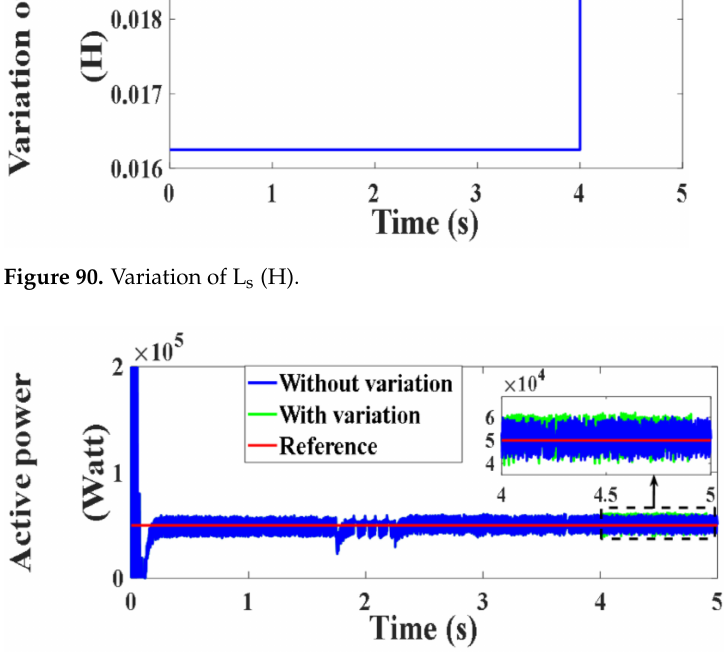
Figure 91. Active power under PVC (Watt).